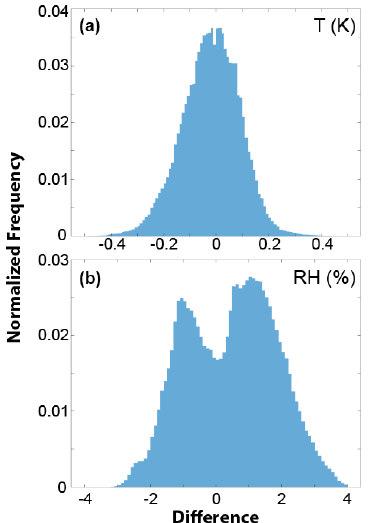
Figure 4. Distributions of differences in the RSS421-measured temperatures (a) and relative humidities (b) for all times the aircraft was in flight during the ATOMIC